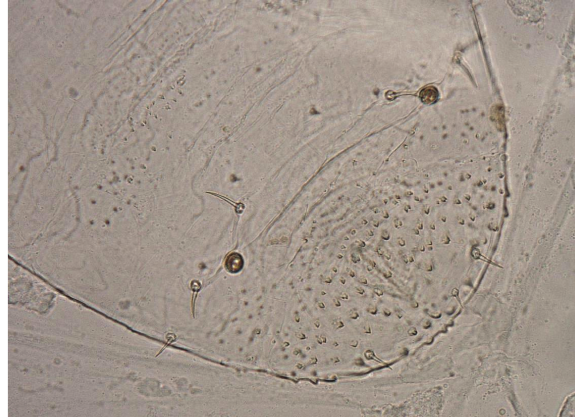
Figure 15: Setiform papillae flanking the spiracle on abdominal segment eight: one dorsal and two pleurals on each side.